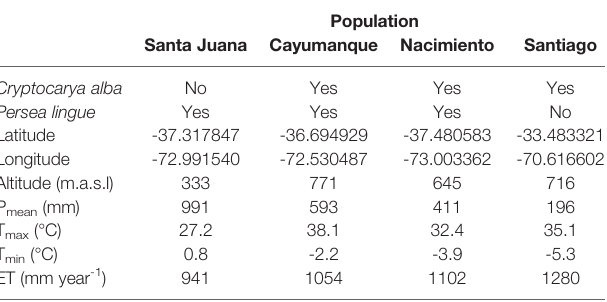
TABLE 1 | Characteristics of the sites where Cryptocarya alba and Persea lingue populations were